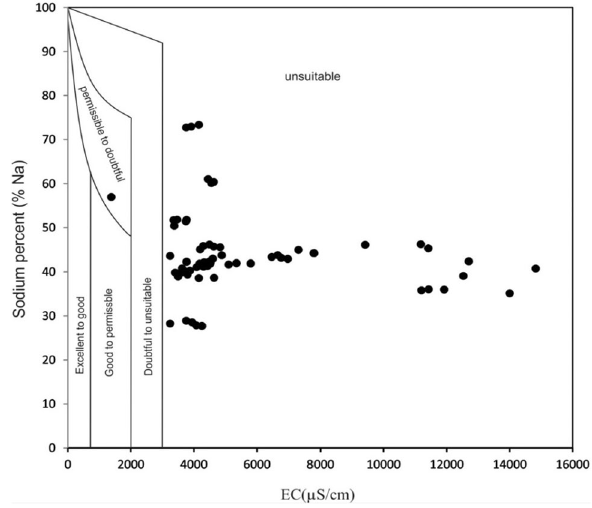
Fig. 14 Plot of classification of irrigation waters (after Wilcox